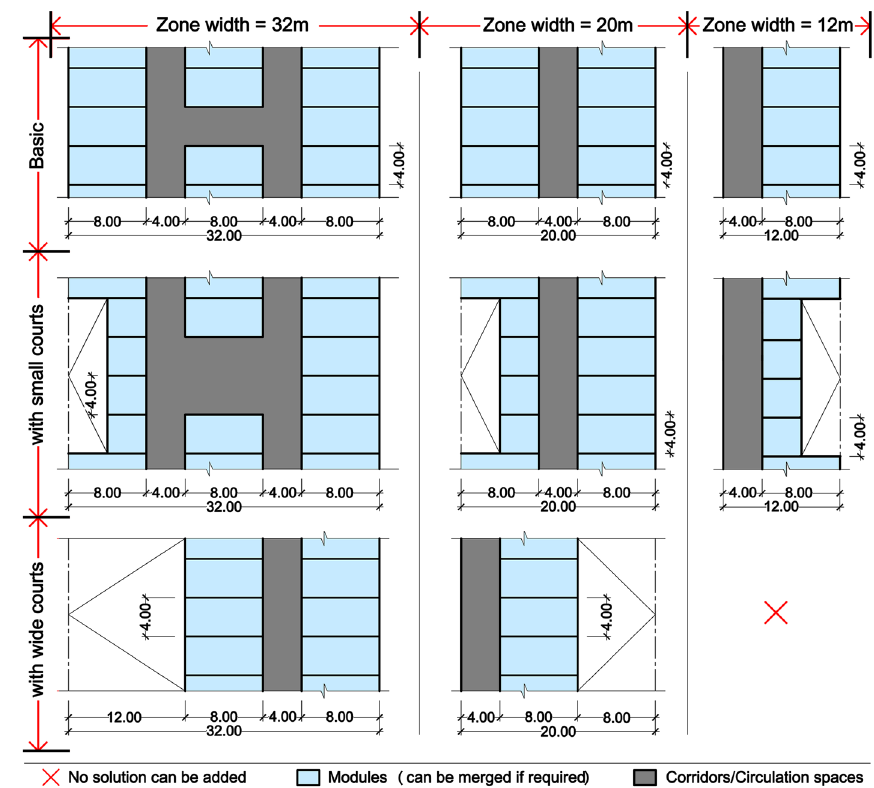
Fig. 1 Proposed dimensions to be considered in the design of